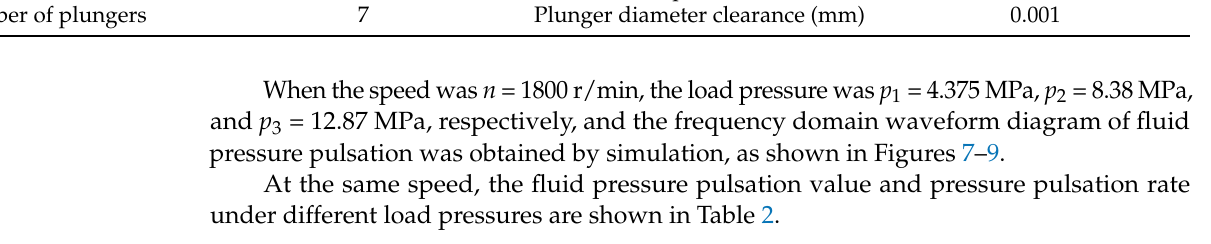
Table 2. Numerical simulation of fluid pressure fluctuation and pressure fluctuation rate under different load pressures. Rotating